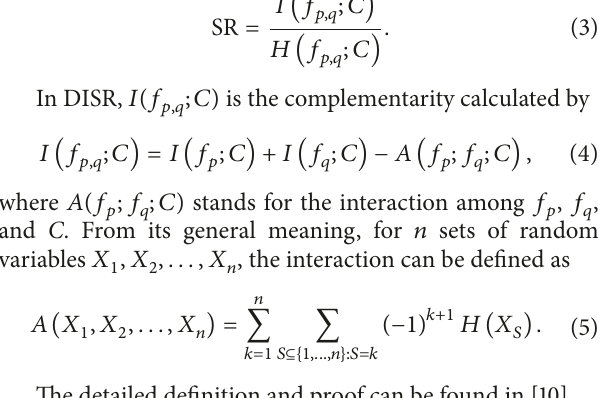
Figure 1: Procedure of RFWF